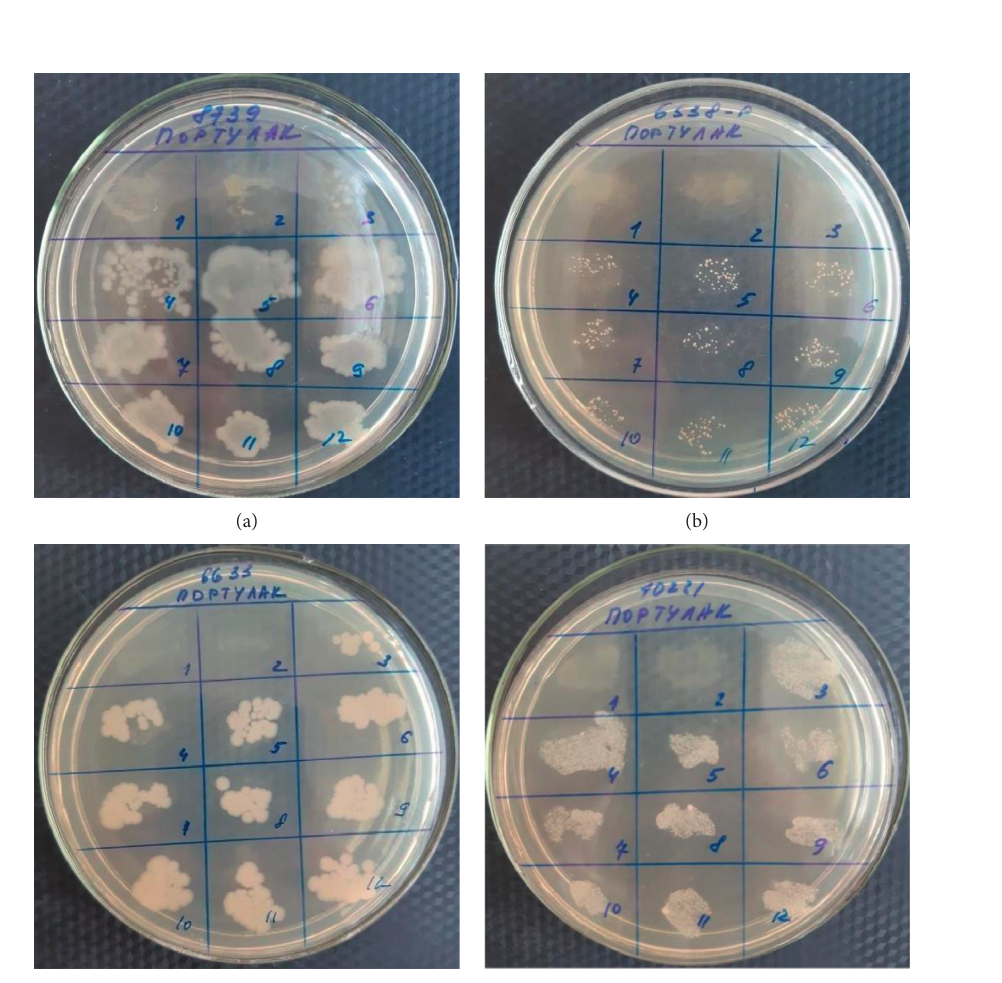
Figure 1: Results of the antimicrobial activity of Portulaca oleracea ’s CO2 extract obtained by the serial dilution method from the Almaty region (Southeast Kazakhstan, 2019): ( a ) E . coli ; (b) S . aureus ; (c) B . subtilis ; and (d) C . albicans . After studying the antimicrobial effect of Portulaca oleracea ’s CO 2 extract by the disco-diffuse method, its activity was also established. During interpreting the data, it was conditionally accepted that the diameter of the growth zone delay was over 15mm- high activity, 10–15mm- medium activity, and less than 10mm- low activity (Table 5, Figure